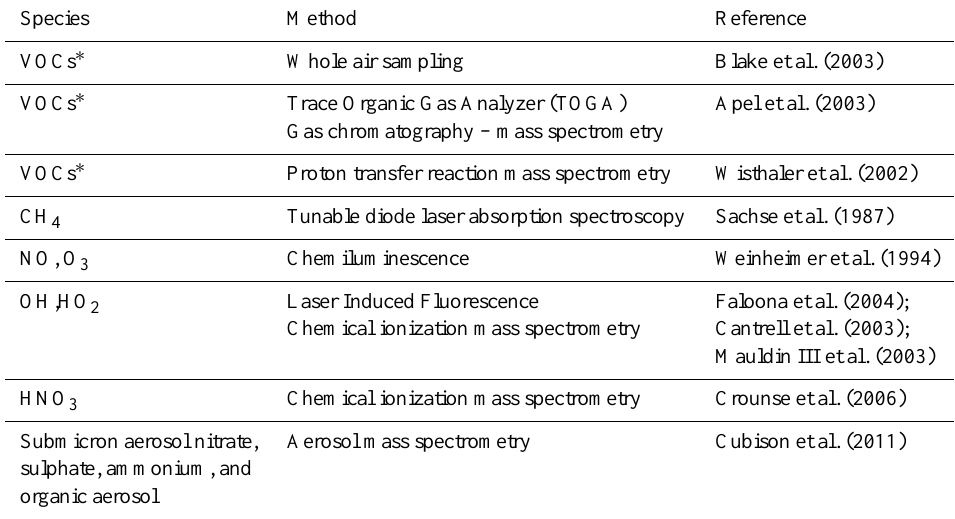
Table 1. Species and measurement techniques used in this paper in addition to the core measurement of 6 ANs and NO 2 . Species